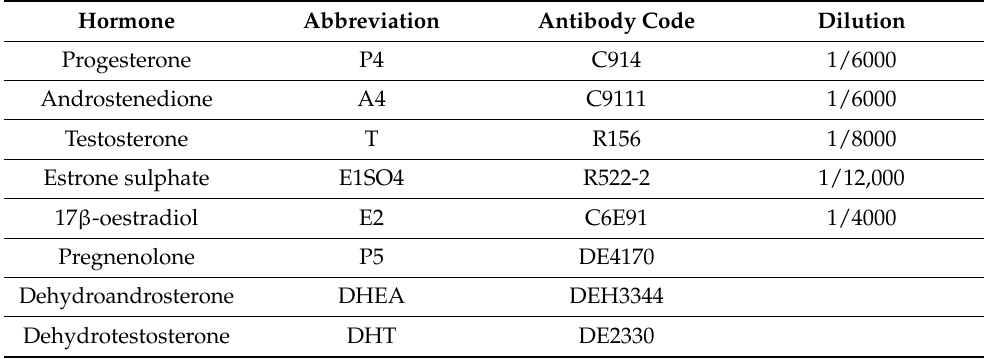
Table 1. Steroid hormones assayed and antibodies used for EIA determinations. P5, DHEA and DHT were determined using commercial kits following manufacturer’s